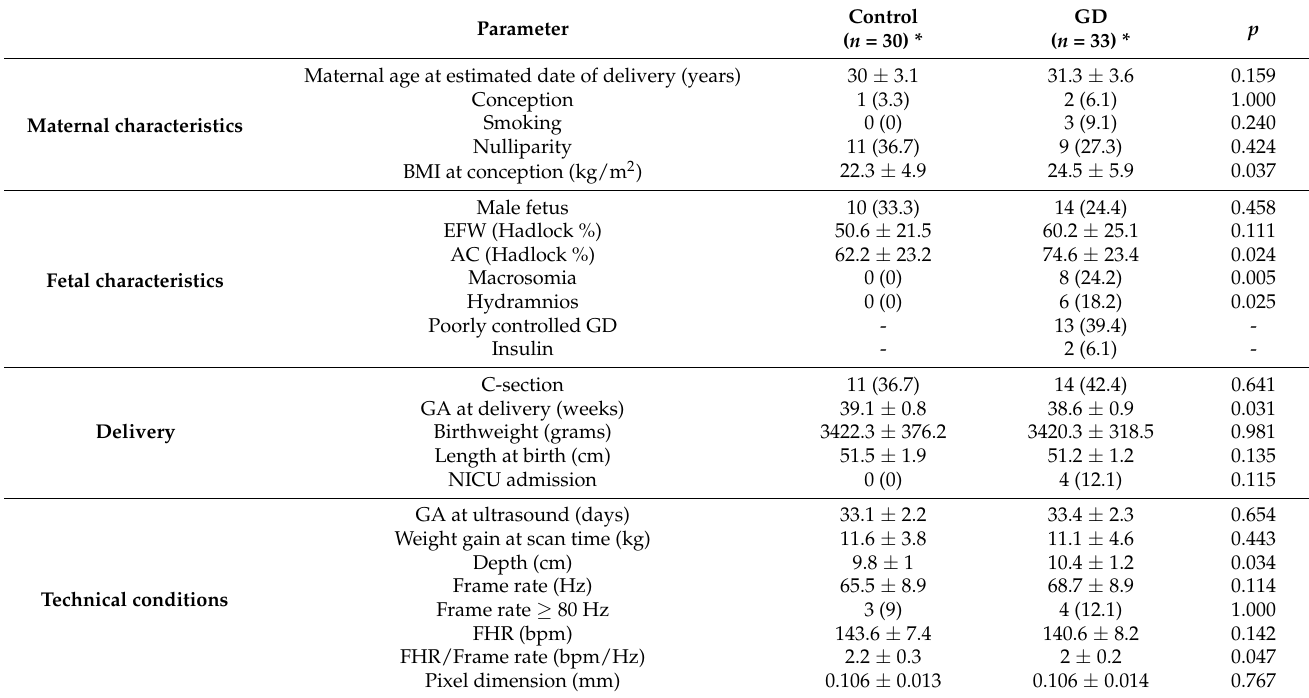
Table 1. Baseline characteristics of the Control group and GD